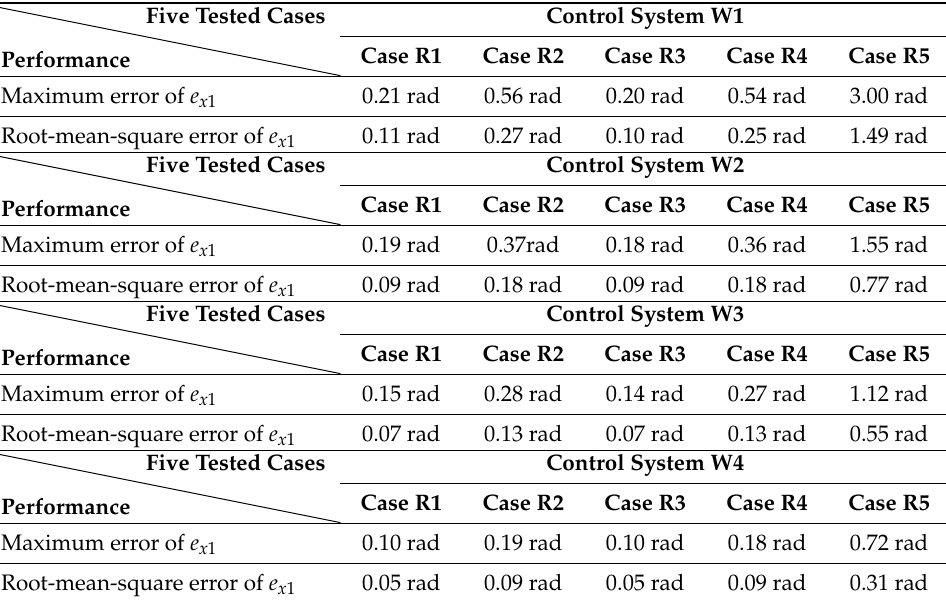
Table 1. Performance comparison of control